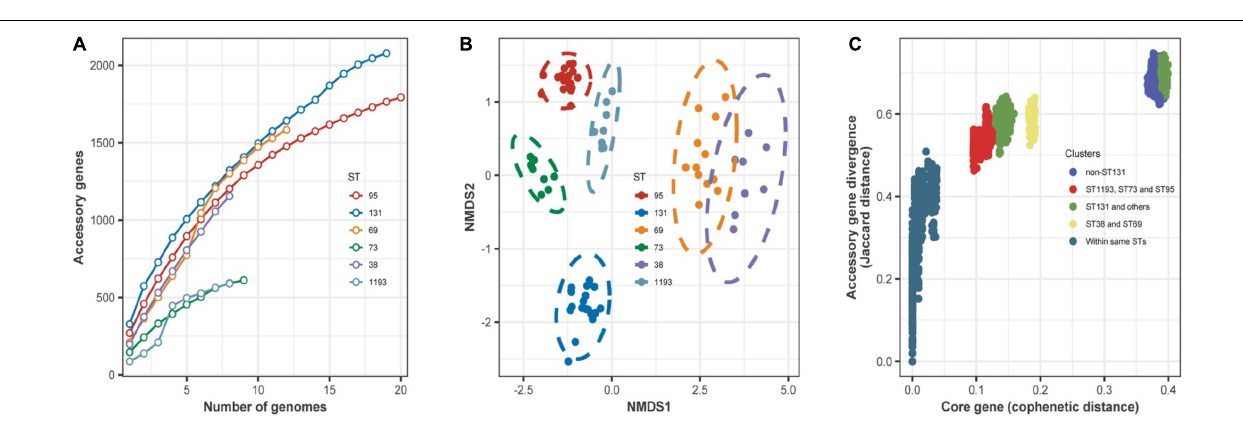
FIGURE 4 | (A) Accumulation of accessory genes ( y -axis) as a function of the number of sampled genomes ( x -axis) in the dominant STs. For the six different STs, there was a steady increase in the number of new genes identified with increasing sampling, and there was no evidence of saturation in any ST. These accumulation curves fit Heaps’ law. The derived constant α was less than 1 for all STs, indicating an open pangenome. (B) Non-metric multidimensional scaling plots of the dominant STs based on shared accessory genes. Dotted lines are 95% confidence limits around the centroid for each ST. (C) Comparison of core and accessory genomes of the dominant STs. Each circle is the core genome similarity, plotted as cophenetic distance ( x -axis) as a function of accessory gene similarity ( y -axis, Jaccard distance) for each paired comparison within the different groups indicated in the key. Intra-ST comparisons of isolates (dark blue dots, bottom left) indicated little difference in core gene content, with clustering by the origin. In contrast, pairwise comparisons between all isolates of different STs other than ST131 (bright blue dots, top right) form a separate cluster. This discontinuity reflects a distinct clonal structure of the population, because a higher rate of recombination between STs can generate a more homogeneous distribution. Comparison of ST131 with all other isolates indicated two clusters (green dots). Comparison of ST73, ST95, and ST1193 indicated more similarity in core gene divergence and accessory gene content (red